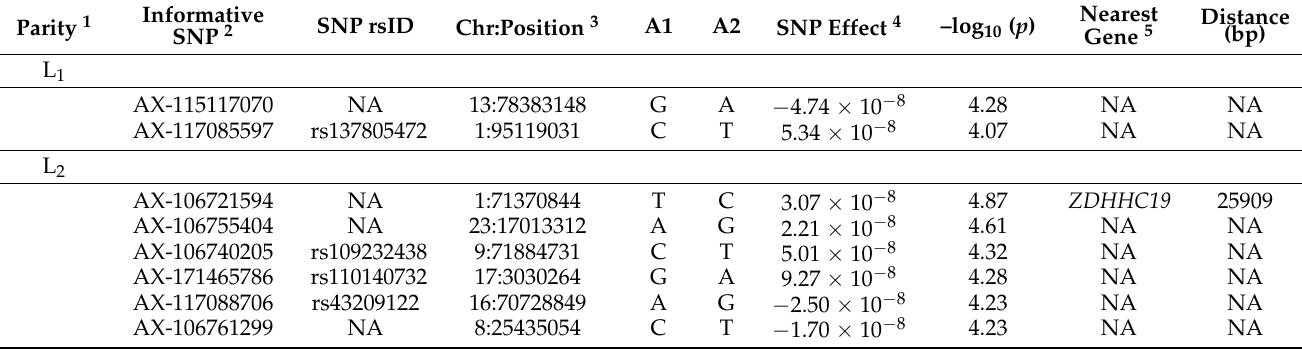
Table 2. List of single nucleotide polymorphisms (SNPs) in the Bos taurus autosomes showing significant ( − log 10 ( p ) ≥ 4.00) associations with SCS in the Romanian Spotted breed. Parity 1